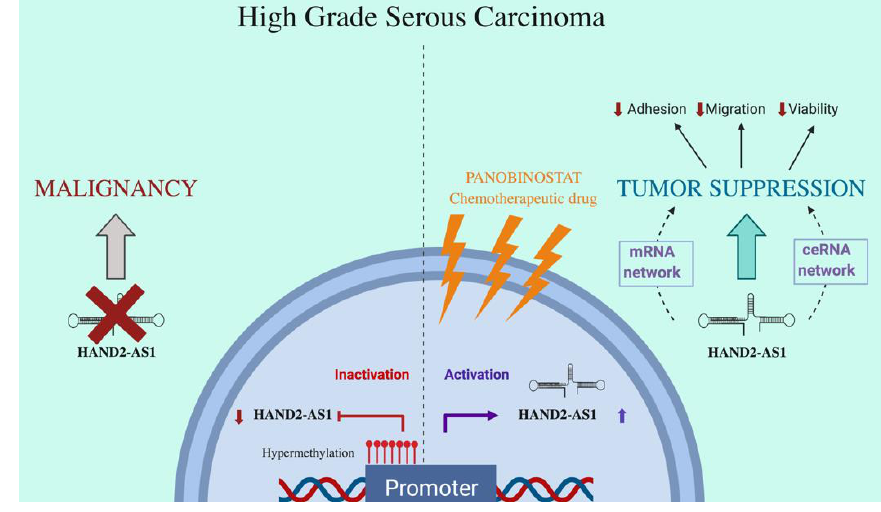
Figure 7. Schematic summary of the role of HAND2-AS1 in HGSC. - denotes downregulation, - - denotes